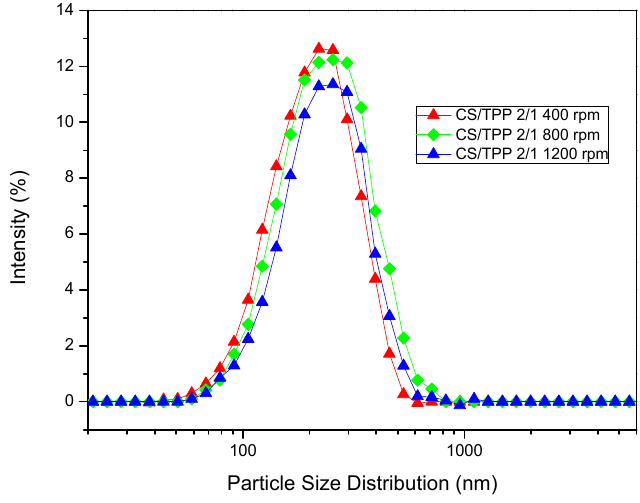
Figure 1. Dynamic light scattering (DLS) curves of CS/TPP 2/1 nanoparticles prepared at different stirring rates.